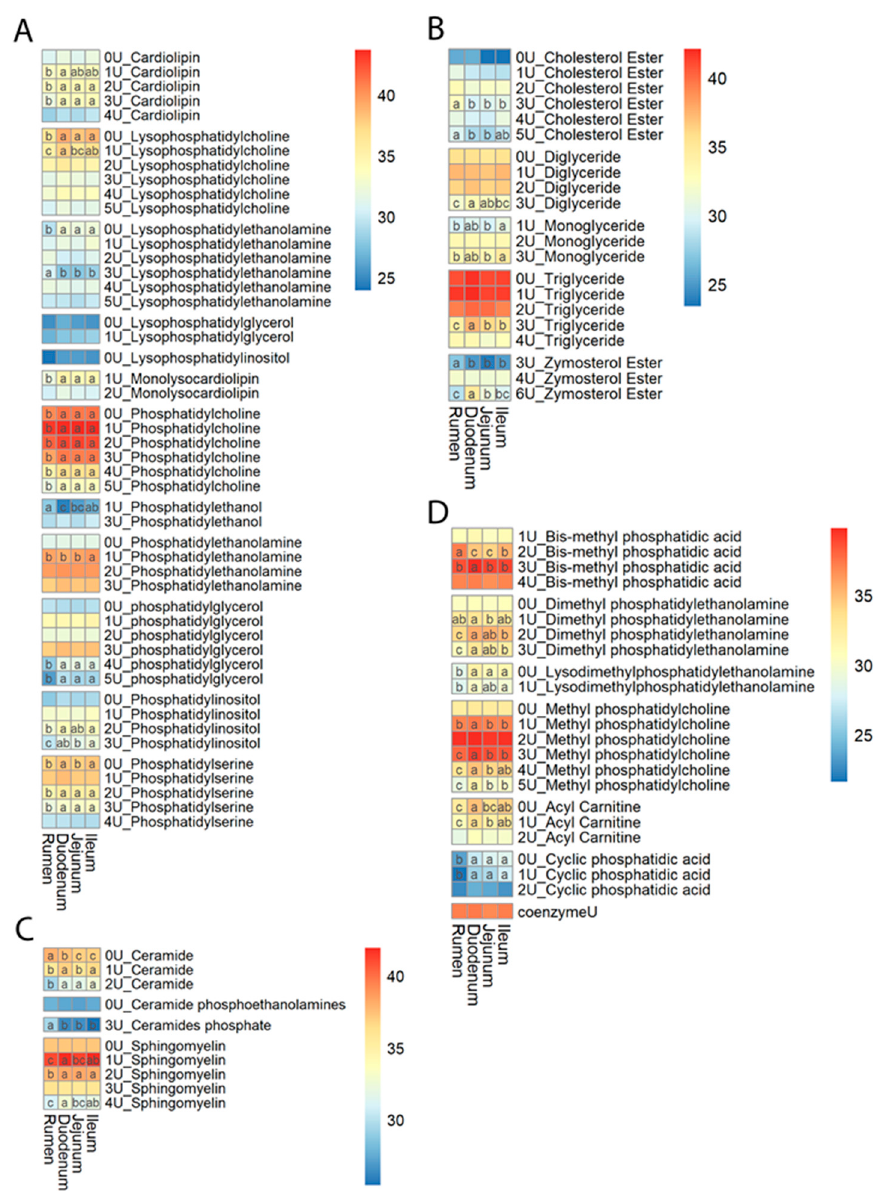
Figure 4. Signal counts of the average degree of unsaturation in each lipid class across the ruminal papillae and epithelium from duodenum, jejunum, and ileum of 5 lactating Holstein cows (( A ) phos- pholipids, ( B ) neutral lipids, ( C ) sphingolipids, ( D ) derivatized lipids, fatty acyl, and other lipids). The letter U and a number denote the average degree of unsaturation. Red denotes high signal counts, yellow median signal counts, and blue low signal counts for each lipid class. a,b,c Means with on the same row differ ( p < 0.05).